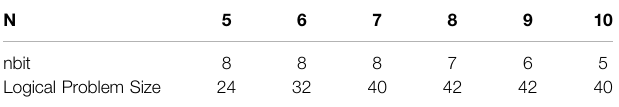
TABLE3| Sizeofthelogicalproblemwithincreasingnumberofgridpoints N (here N includes the boundary points) and precision n .